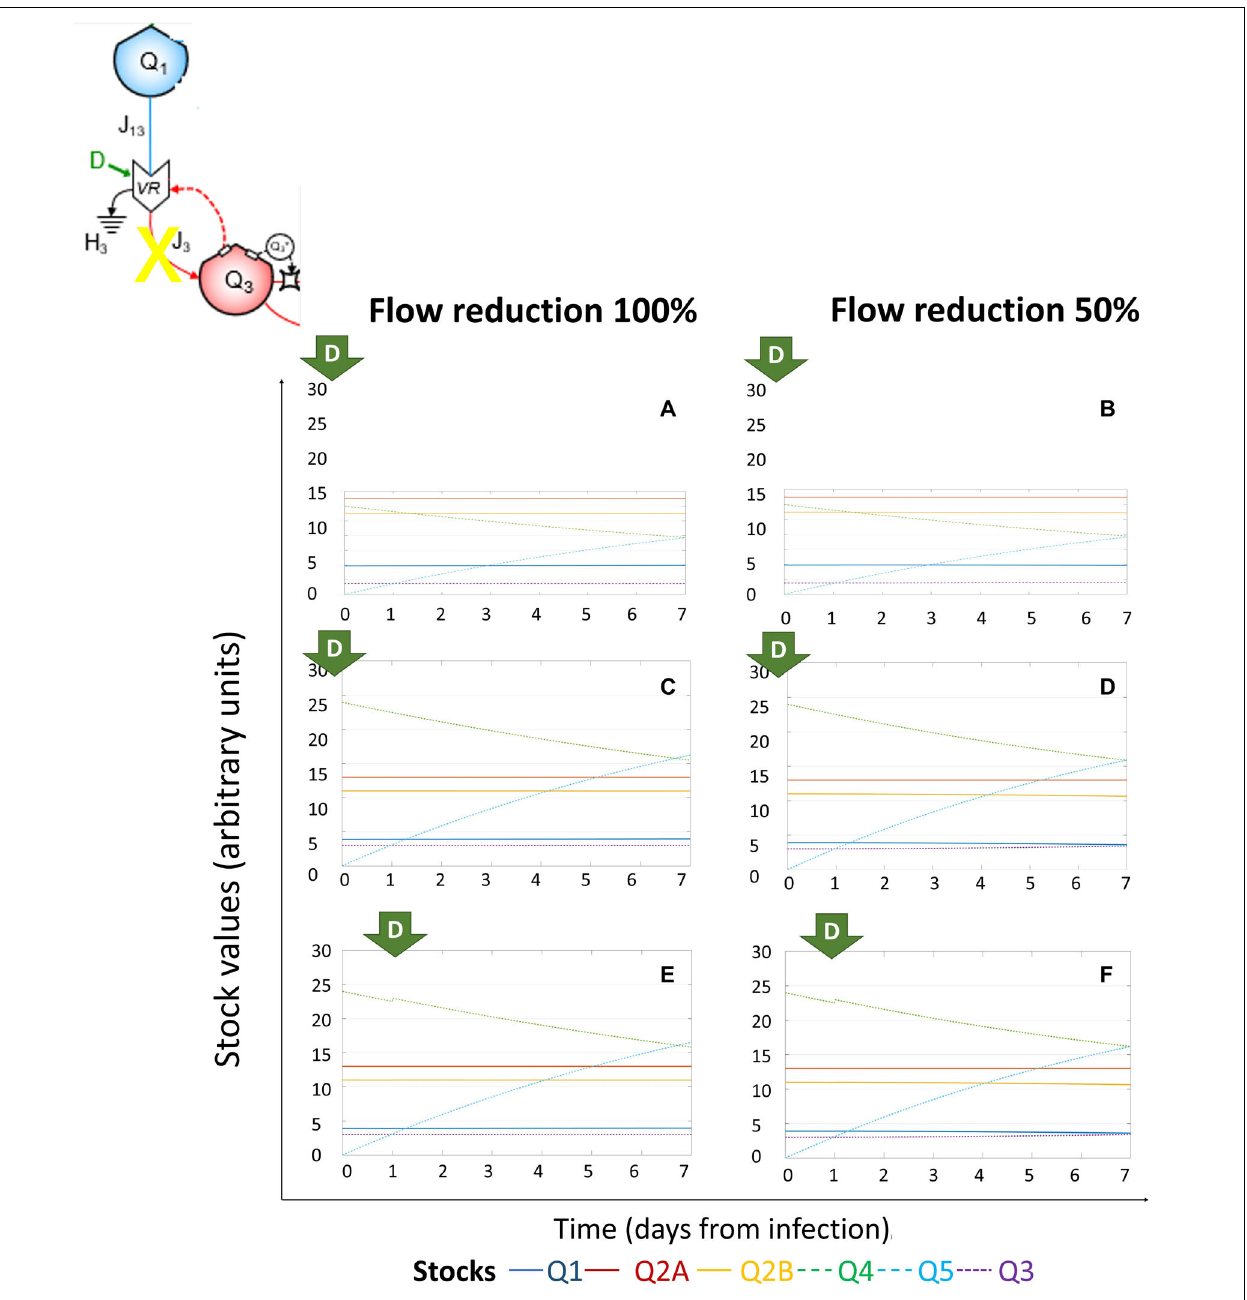
FIGURE 7 | System dynamics of (+)ssRNA virus–host interaction in response to external driving forces applied to reduce viral RNA replication. Changes over time of the values of each stock of the system diagrammed in Figure 1 (for the color code, see bottom), expressed in ATP-eq, in response to reduction of J 3 (flow of energy required for RNA replication). Several scenarios are shown: initial viral load 5k and application of full (100%, A ) or partial (50%, B ) J 3 reduction at Day 0; initial viral load 10k and application of full (100%, C ) or partial (50%, D ) J 3 reduction at Day 0; initial viral load 10k and application of full (100%, E ) or partial (50%, F ) J 3 reduction at Day